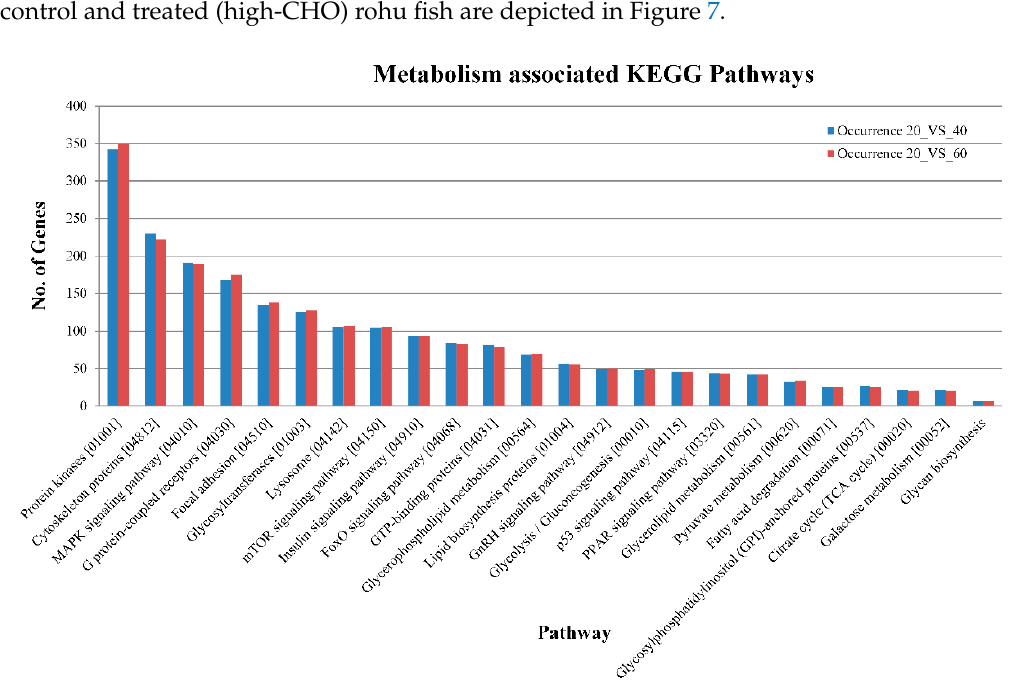
Figure 5. Kyoto Encyclopedia of Genes and Genomes (KEGG) pathway enrichment analysis for selected genes between control (20%) versus fish fed with 40% CHO (blue), and control (20%) versus fish fed with 60% CHO (red), represented on a graph, with pathways on the x ‐ axis and number of genes on the y ‐ axis.